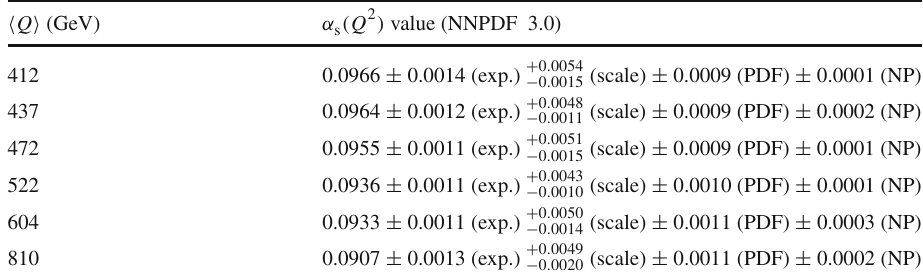
Table 3 Values of the strong coupling constant at the measurement scales, α s ( Q 2 )